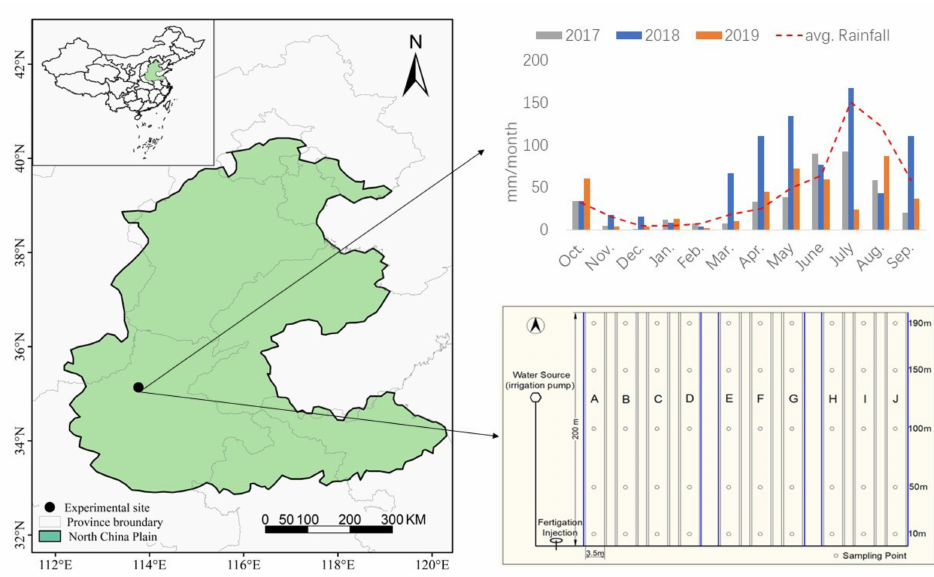
Figure 2. Location of the study area, rainfall pattern and experimental field